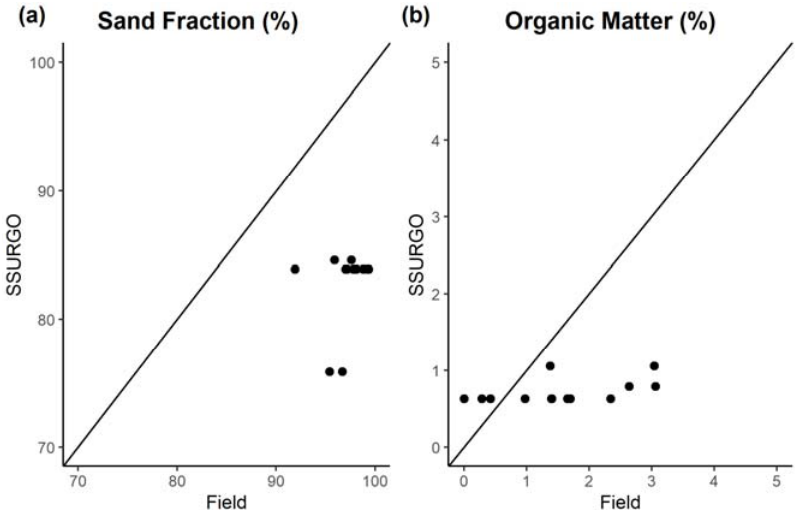
Figure A1. ( a ) Measured sand fraction (%) and ( b ) organic matter content (%) of bank soils at a subset of Farmington River PDP locations compared to the analogous derived SSURGO parameters.